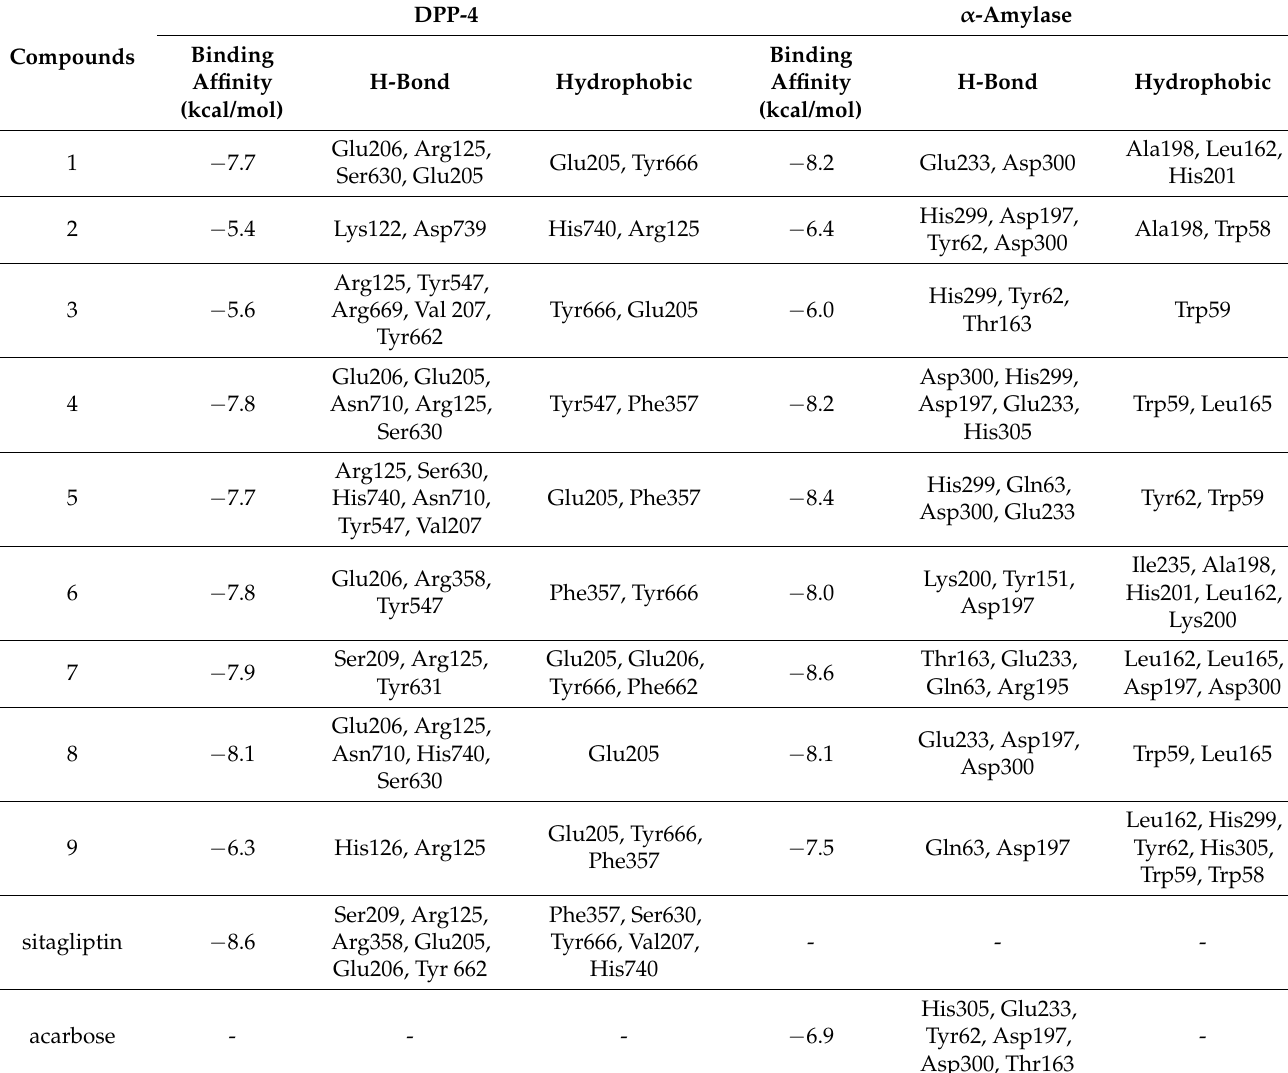
Table 4. Binding affinity and interacting residues of the identified compounds with DPP-4 and α -Amylase enzyme.